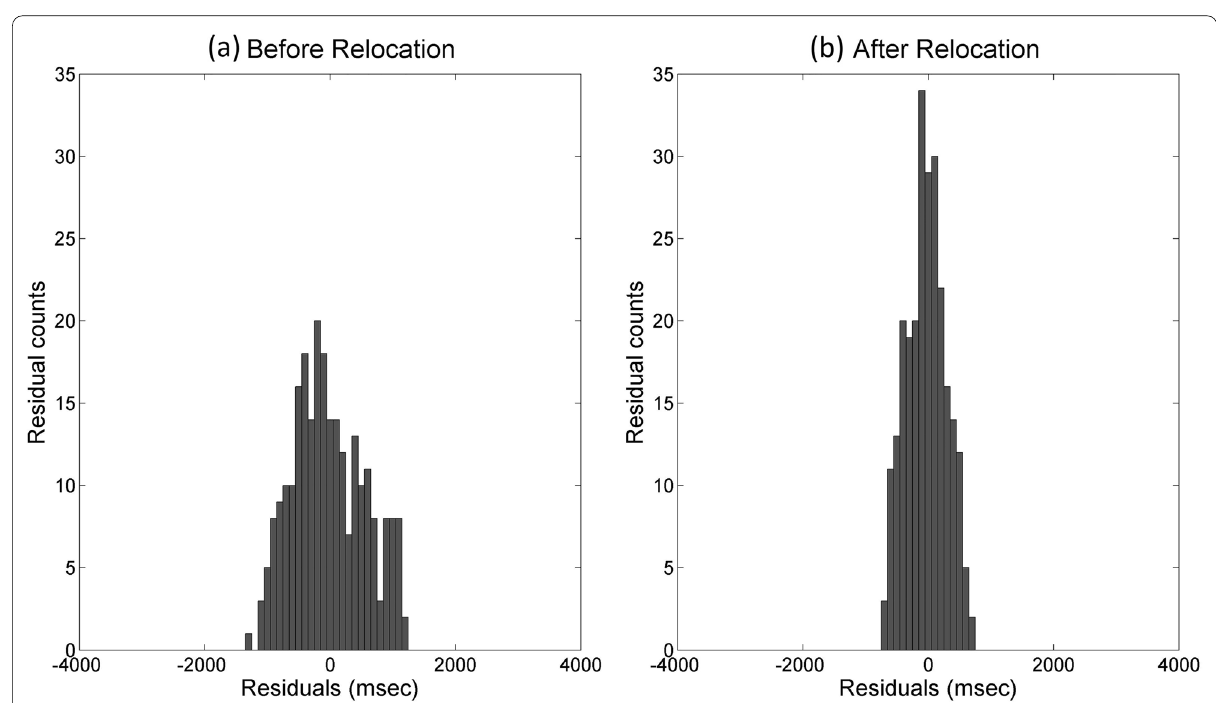
Fig. 9 Histograms of relative residuals of event pairs. a Before relocation; b After relocation using the DD